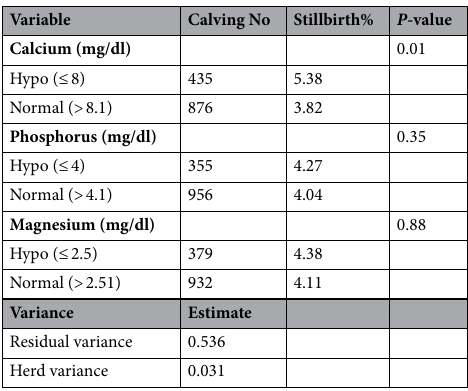
Table 6. Calving number and percentage of stillbirths for selected blood macro-minerals at parturition included in the binary logistic regression model of the generalized linear mixed model for stillbirth incidence in Holstein dairy cows (n = 1311).